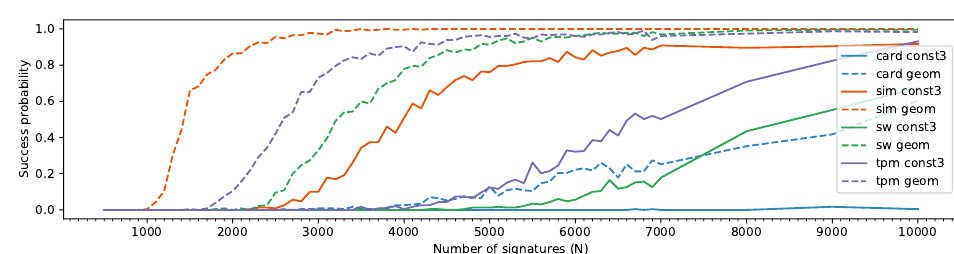
Figure 6: Success rate (averaged over all analyzed dimensions) of geometric bounds and constant c = 3 bounds on the various datasets. Note that better results would be obtained if considering only dimensions above 70 according to Figure 4 and 5.